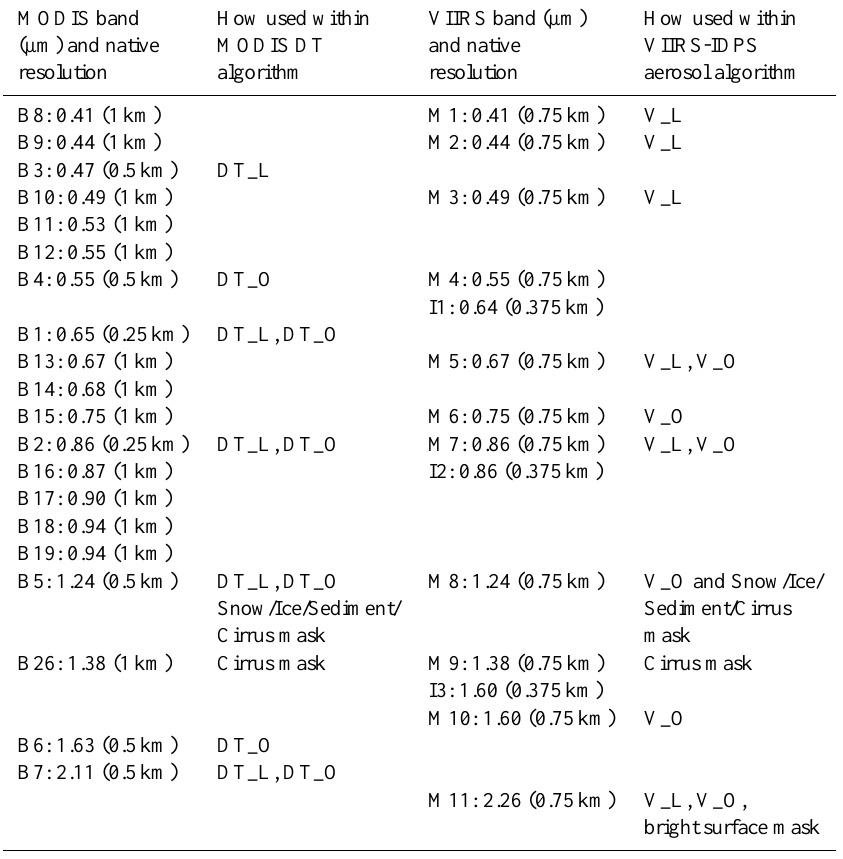
Table 3. MODIS and VIIRS spectral configuration and aerosol algorithm use of channels. MODIS band How used within VIIRS band (µm) How used within (µm) and native MODIS DT and native VIIRS-IDPS resolution algorithm resolution aerosol